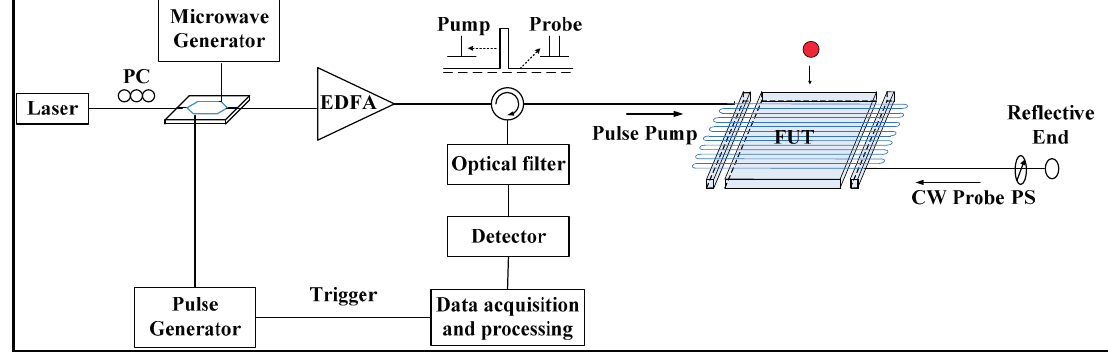
Figure 1. Distributed Brillouin sensor